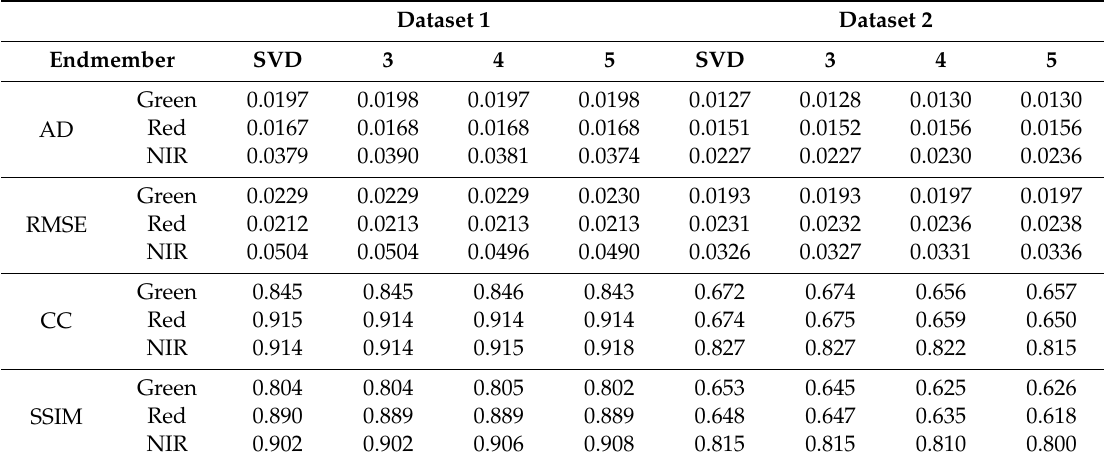
Table 3. The fusion precision of EFSDAF by using di ff erent endmember numbers in two datasets (NIR-red-green).